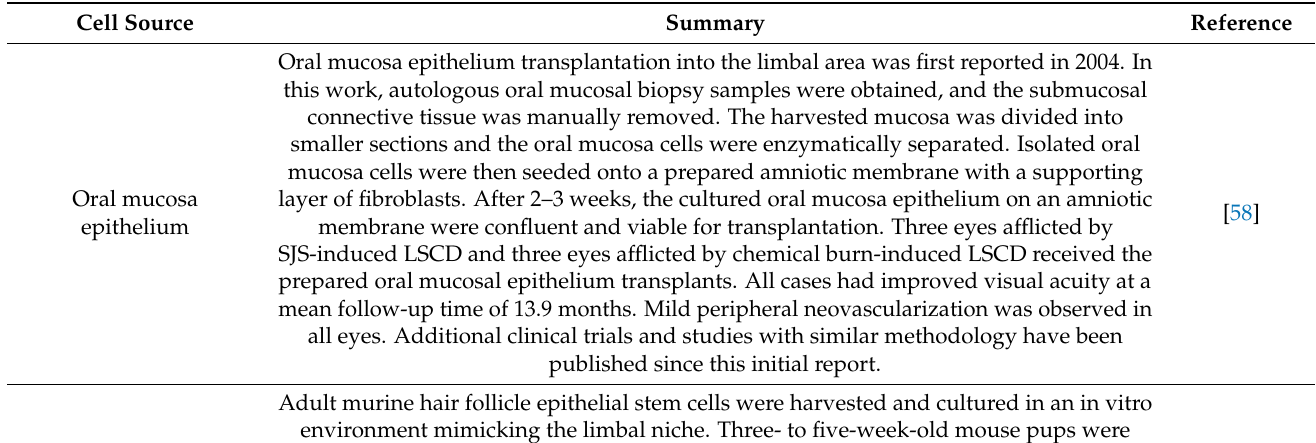
Table 3. Non-limbal stem cells investigated for the ability to differentiate in the limbal niche. Cell